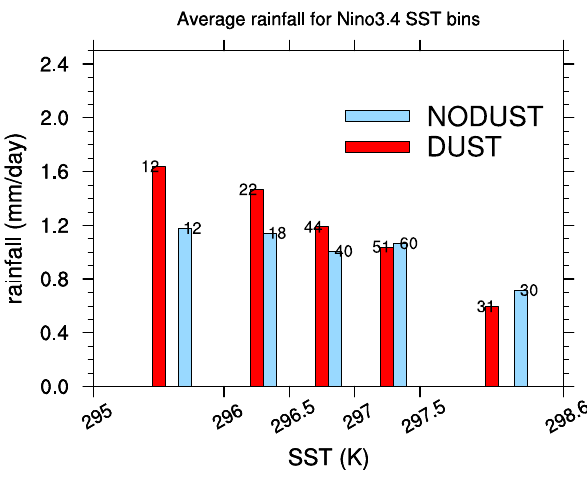
Fig. 7. Rainfall for Ni˜no3.4 SST bins, averaged over the stippled points in eastern Australia from Fig. 6. Red bars are from the DUST run, and blue bars are from the NODUST run. The number of points in each SST bin is shown near the top of each bar. The width of each SST bin is 0.5 ◦ , except for the first and last bins, which have width of roughly 1 ◦